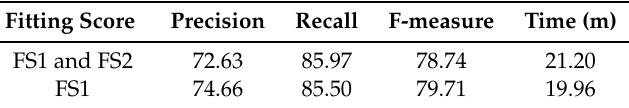
Table 2. Effect of using only the